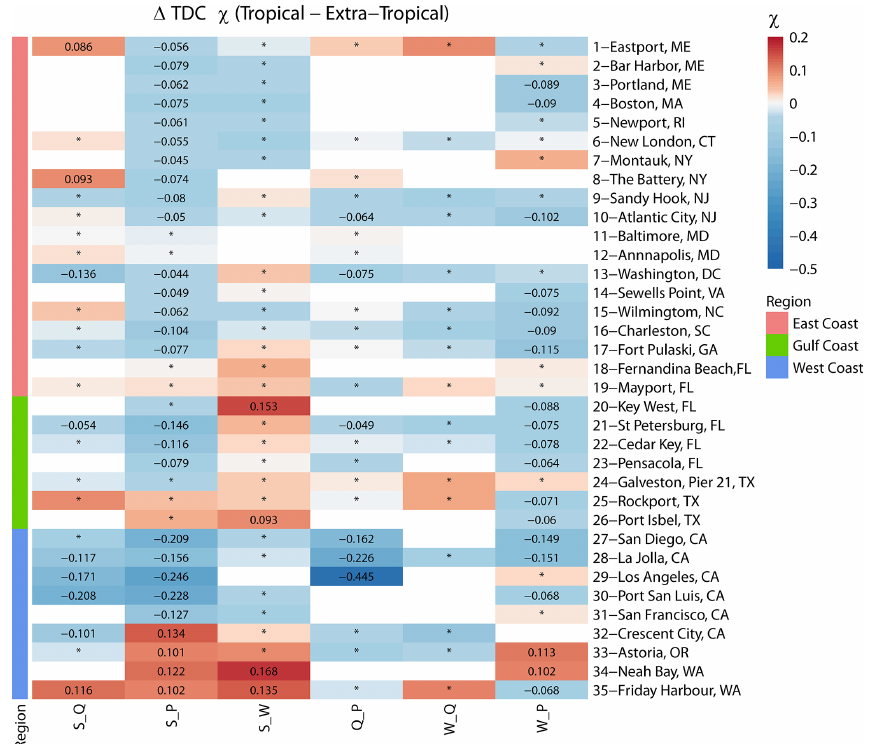
Figure 8. Heat map showing differences in tail dependence (for q = 0 . 9) derived for tropical and extra-tropical seasons using a daily time series of both variables. Sites are grouped into locations on the East, Gulf, and West coasts (see colours on the left and in the legend). The colour bar denotes the difference between χ in the tropical versus extra-tropical season, where the red colour denotes higher dependence in the tropical season, and the blue colour denotes higher dependence in the extra-tropical season. Squares with an asterisk ( ∗ ) indicate that difference in dependence across seasons is not significant. Blank squares indicate that data for the particular pair did not exist or that the number of overlapping years was less than